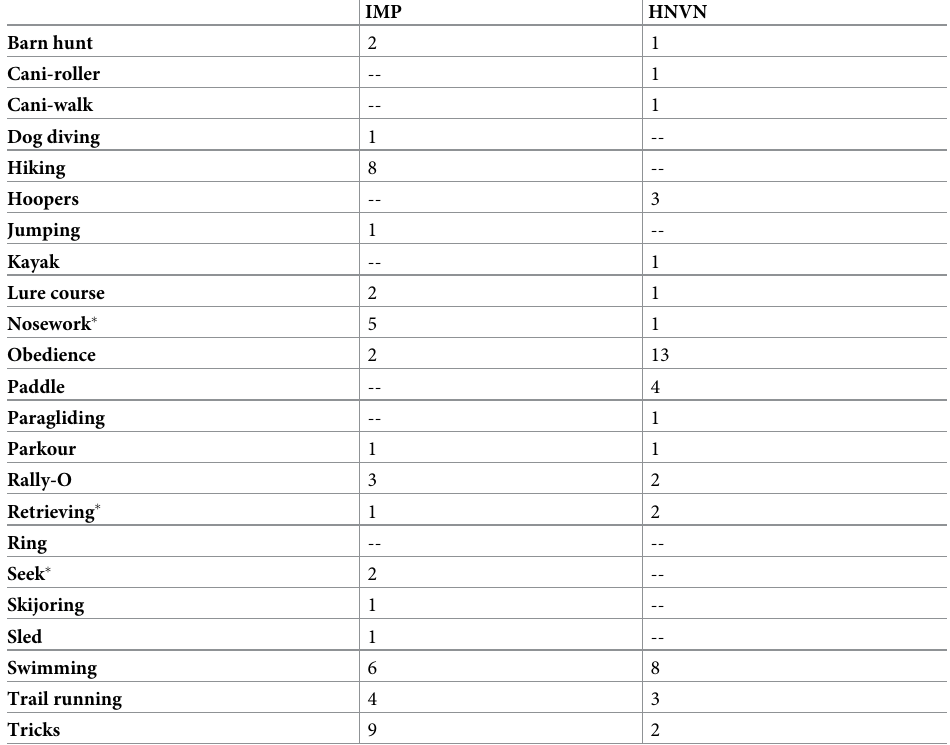
Table 10. Raw numbers of IMP and HNVN dogs for each “other” (non-listed) activity as manually reported by owners. IMP HNVN Barn hunt 2 1 Cani-roller -- 1 Cani-walk -- 1 Dog diving 1 -- Hiking 8 -- Hoopers -- 3 Jumping 1 -- Kayak -- 1 Lure course 2 1 Nosework � 5 1 Obedience 2 13 Paddle -- 4 Paragliding -- 1 Parkour 1 1 Rally-O 3 2 Retrieving � 1 2 Ring -- -- Seek � 2 -- Skijoring 1 -- Sled 1 -- Swimming 6 8 Trail running 4 3 Tricks 9 2 Activities are sorted in alphabetic order. Activities followed by an asterisk strongly rely on olfactory capacities. The “--” symbol means that no dog was